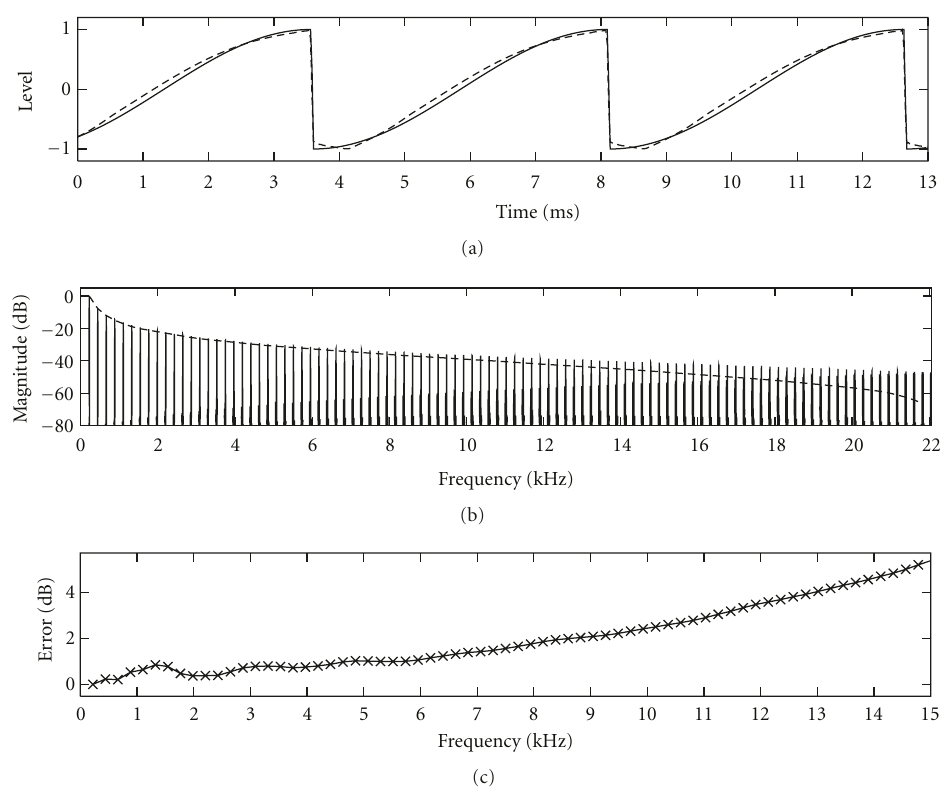
Figure 5: (a) Waveform, (b) the spectrum, and (c) the harmonic magnitude error of the PD model of the Moog sawtooth oscillator output, that is, the di ff erence between the model output harmonic magnitudes and the magnitudes of the recorded signal harmonics, at f 0 = 220 . 62Hz. As the model parameter, the estimated value was used. The waveform and the spectral envelope of the recorded signal is drawn with a dashed line in (a) and (b), respectively, for